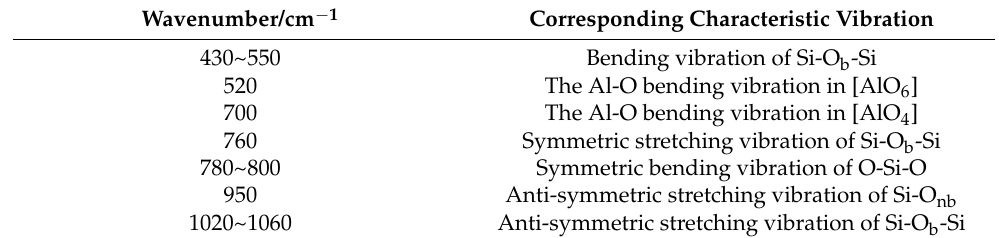
Figure 2. Infrared spectra of S1–S5. Table 3. Characteristic vibrations of CAMS glass.